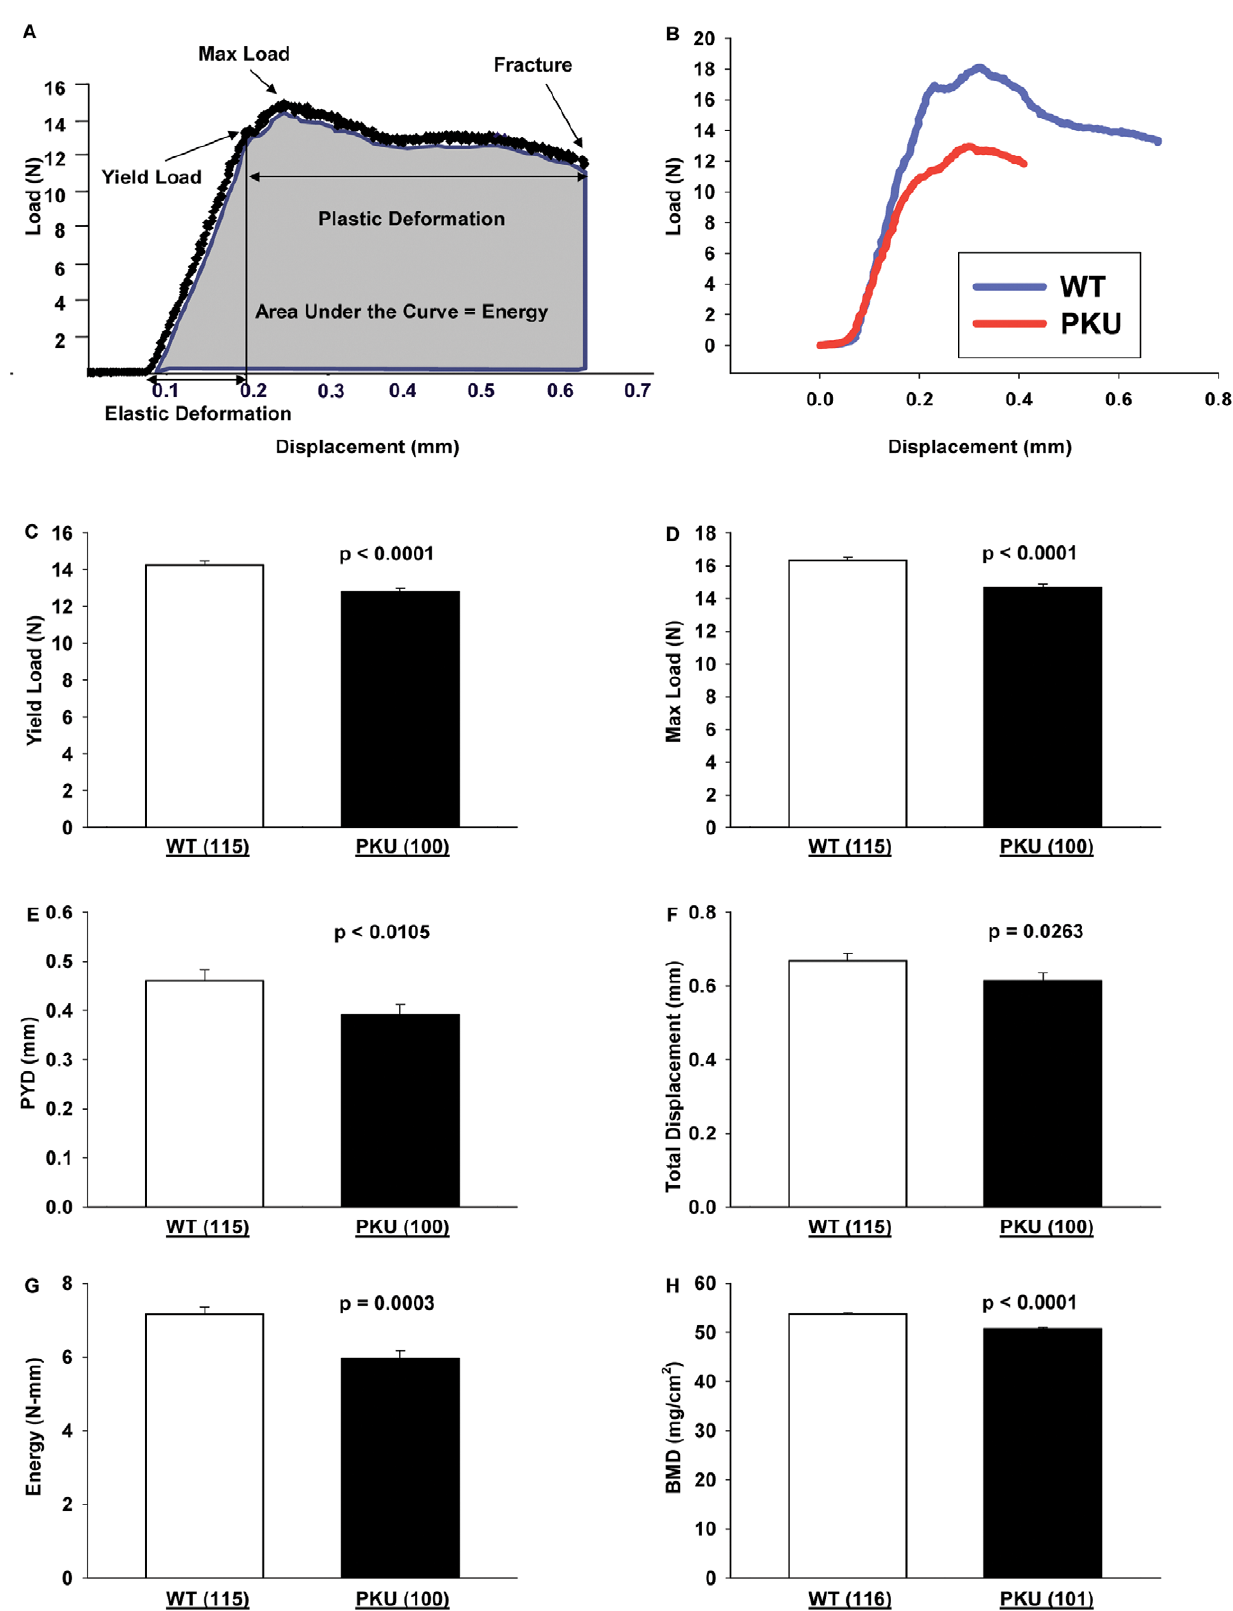
Figure 2. Force-displacement curve analysis of WT and PKU mice. Schematic of a load-displacement curve generated from the three-point bending test from which the yield point, maximum load, elastic and plastic deformation, and energy to failure (shaded area under the curve) are